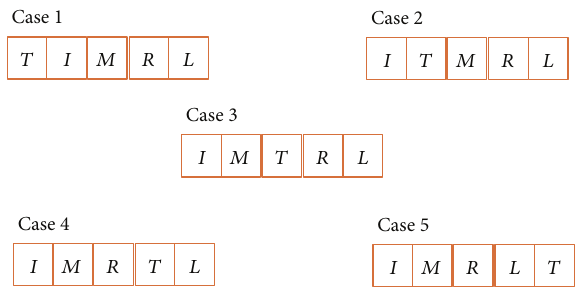
Figure 6: The combinations of thumb in different positions.